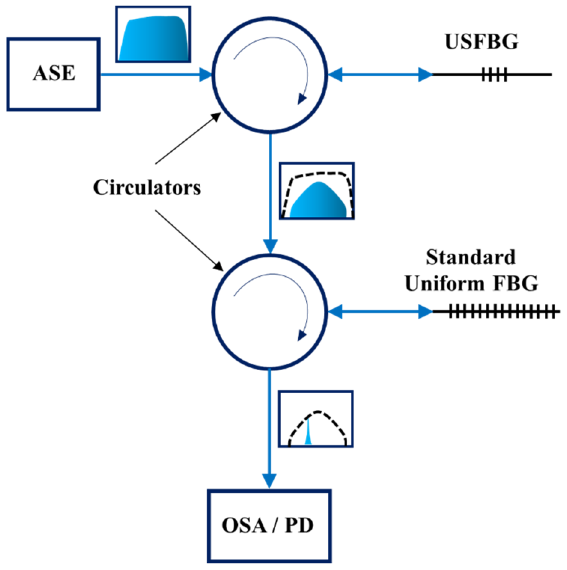
Figure 3. Schematic representation of the setup used to interrogate a uniform FBG, employing a USFBG as the edge filter.